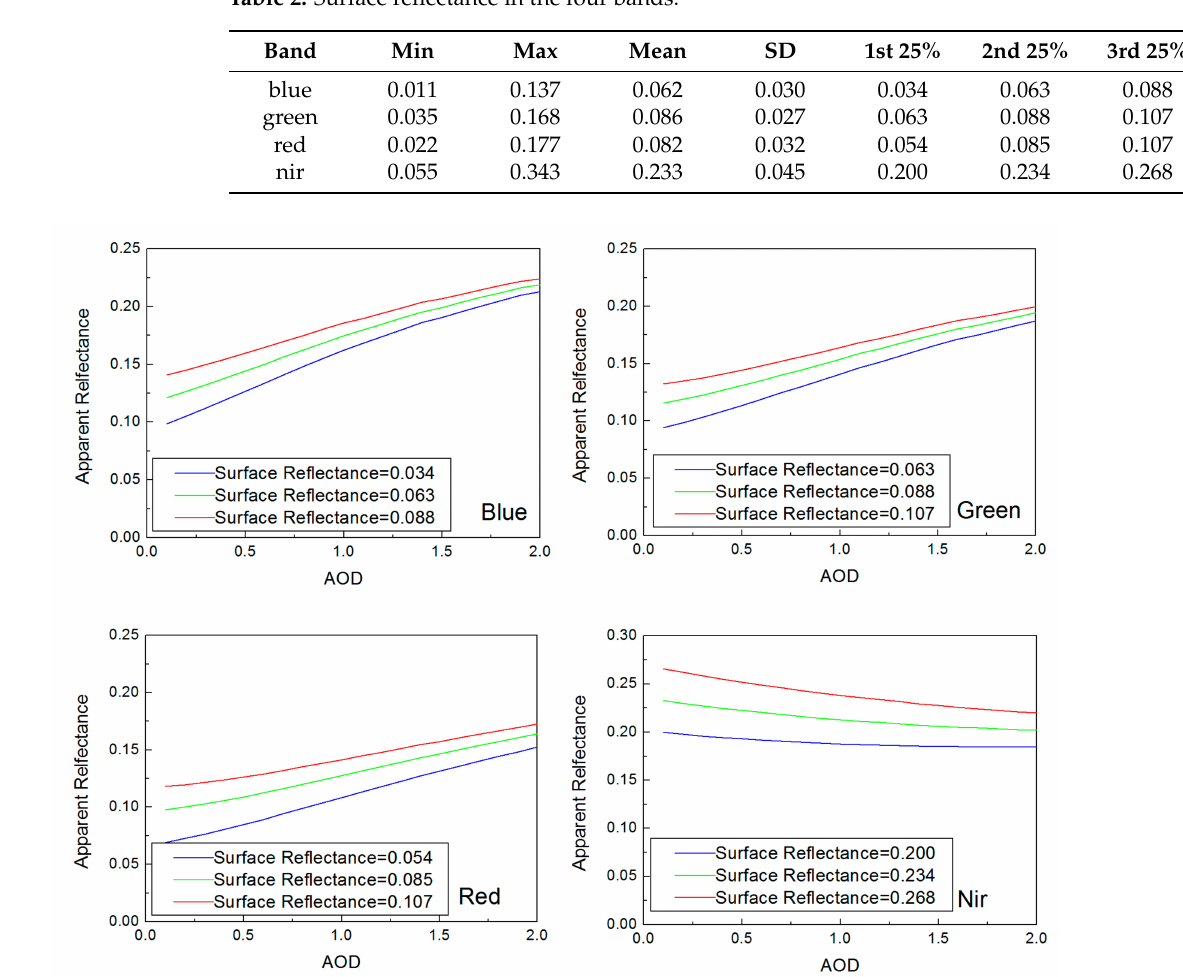
Figure 6. Top of atmosphere (TOA) reflectance in the four bands with different AODs. The correlation between the NDVI and surface reflectance in blue band was